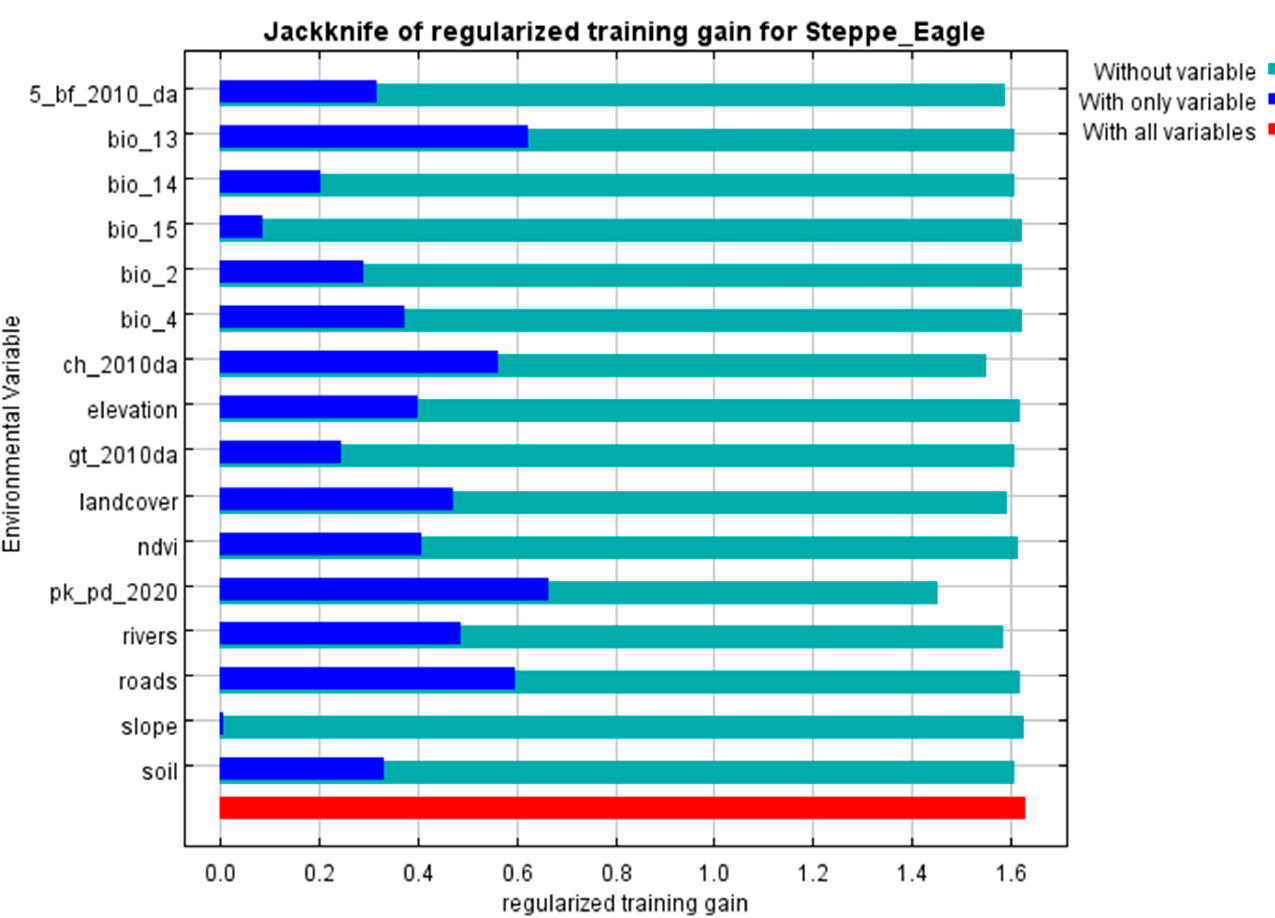
Figure 2. Steppe eagles habitat selection response curves for highly contributing variables. Response curves of predictors for steppe eagle occurrence in Pakistan. Note: The red curves show the mean response of the ten replicate MaxEnt runs, while the mean +/ − one standard deviation is indicated by blue (two shades for categorical variables). The predicted value of habitat suitability (logistic output) is shown on the Y-axis, while the range of the environmental predictors is shown on the X-axis.